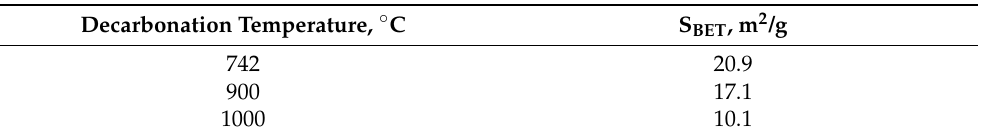
Figure 3. CO 2 uptake capacity evolution of the sorbent over cyclic carbonation–decarbonation at different decarbonation temperatures. The carbonation is performed in the gas flow containing 15 vol.% CO 2 at 630 °C. The insert shows the carbonation profiles of the 25th cycle at different decarbonation temperatures. Table 3. The sorbent-specific surface area after the 25th carbonation–decarbonation cycle at different decarbonation temperatures.